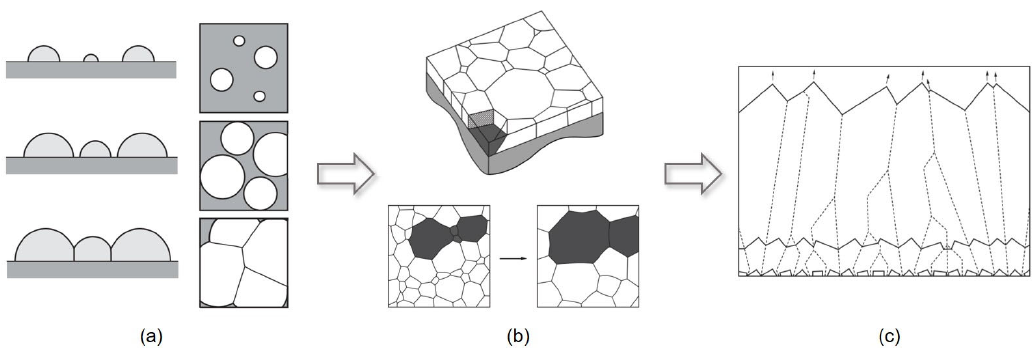
Figure 5. Overview of grain structure evolution during deposition of coatings: ( a ) nucleation; ( b ) growth; ( c ) thickening.